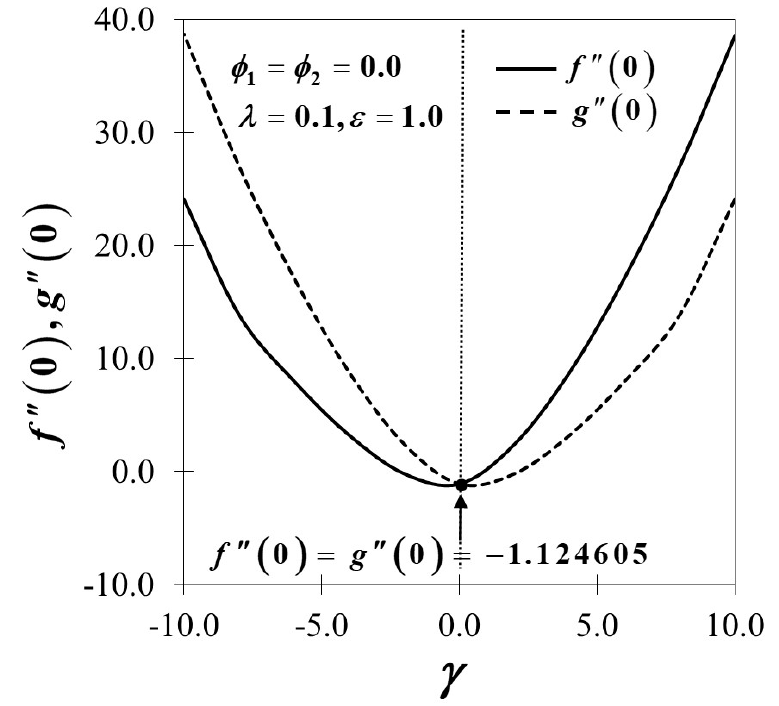
Figure 2. Variations of f (cid:48)(cid:48) ( 0 ) and g (cid:48)(cid:48) ( 0 ) for di ff erent values of γ